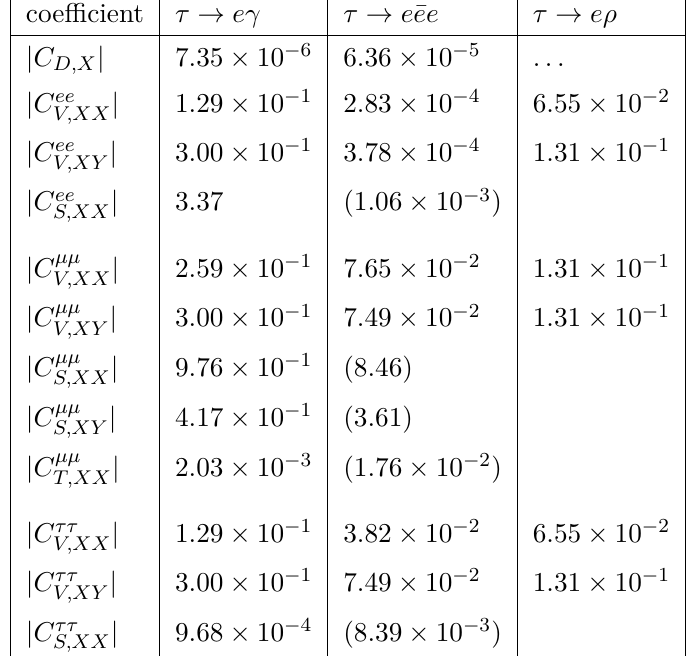
Table 8 . Current sensitivities of the processes in the first row, to the coefficients C eτ... at m W , of τ ↔ e flavour-changing, QCD × QED-invariant 2- and 4-lepton operators, defined as